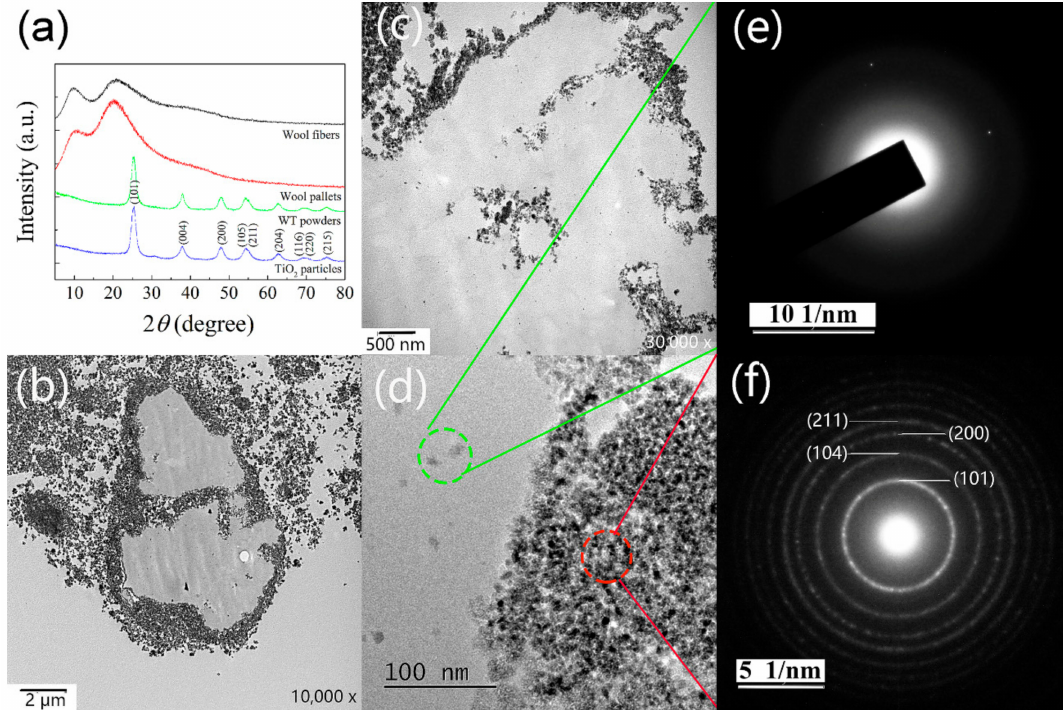
Figure 2. ( a ) XRD patterns of wool pallets before and after loading TiO 2 ; ( b – d ) TEM images of the cross-section of WT powders and the ( e , f ) corresponding SAED